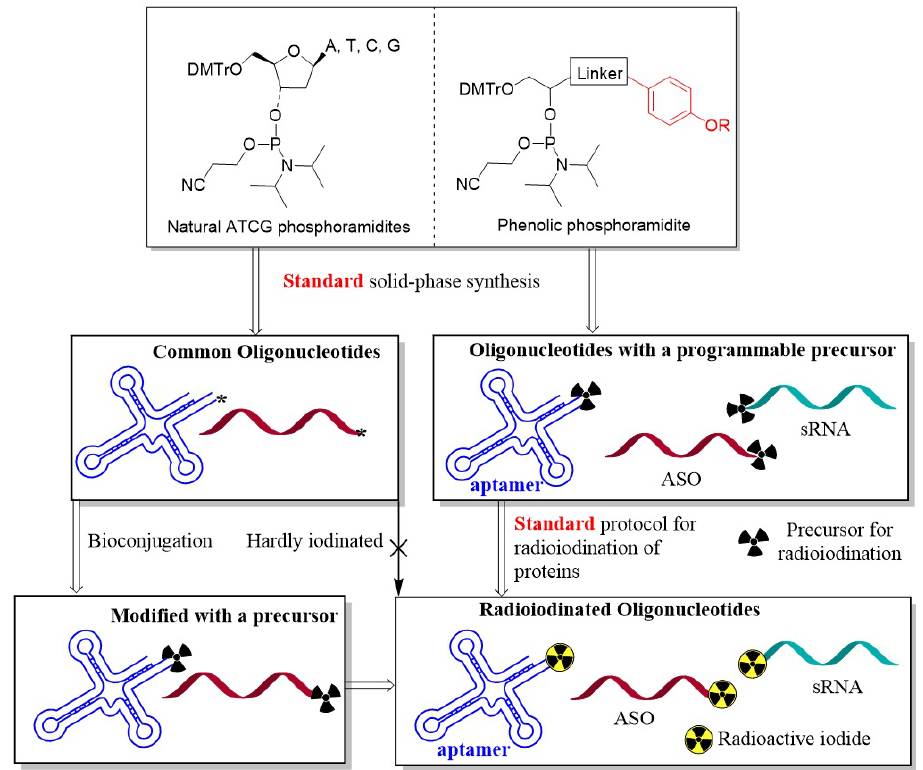
Figure 1. The rationale for site-specific and efficient radioiodination and the advantage over the traditional route (* represent reactive functionalities for bioconjugation).